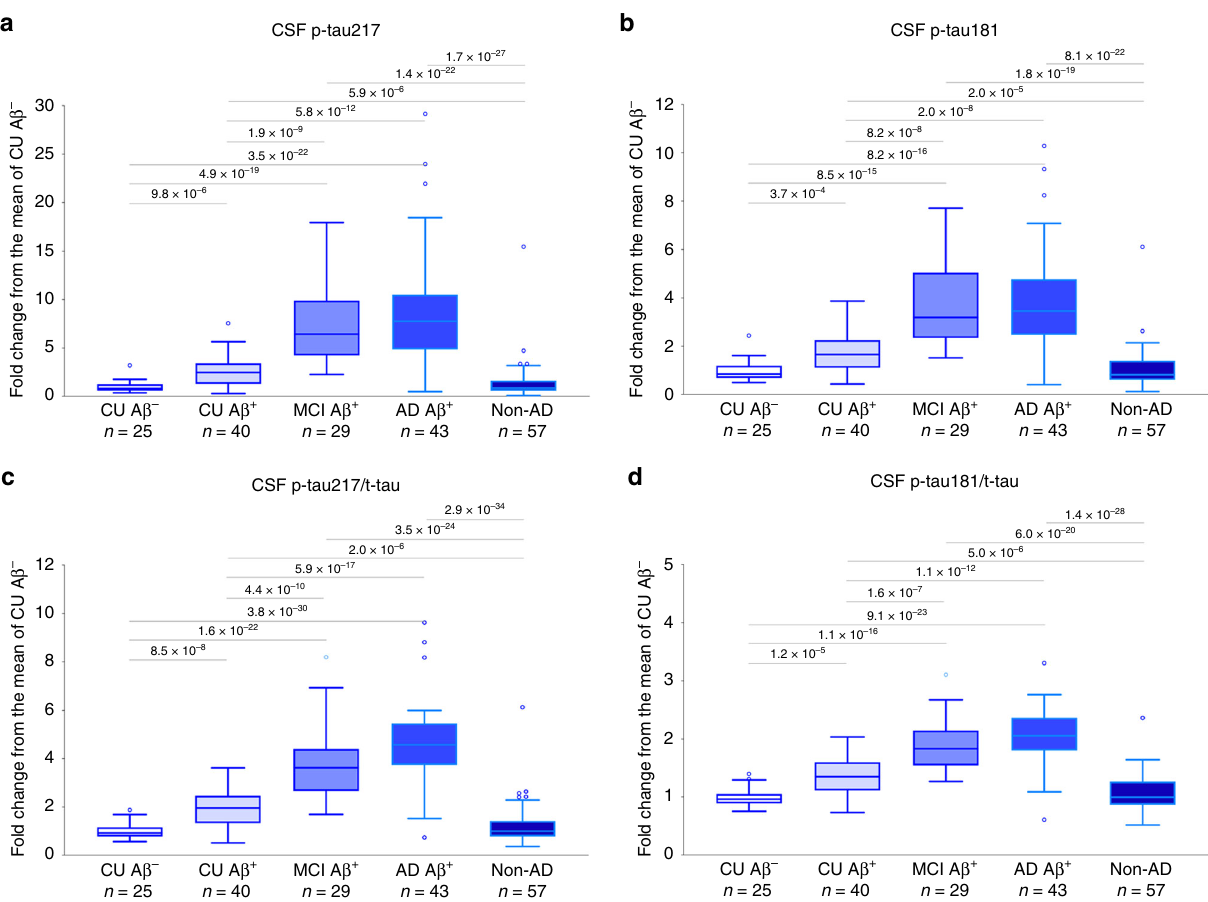
Fig. 1 CSF p-tau in diagnostic groups. a CSF p-tau217, b CSF p-tau181, c CSF p-tau217/t-tau, and d CSF p-tau181/t-tau in CU A β + ( n = 25), CU A β + ( n = 40), MCI A β + ( n = 29), AD A β + ( n = 43) and non-AD neurodegenerative disorders ( n = 57). Non-AD neurodegenerative disorders group included 10 PD, 17 PDD, 6 PSP, 7 DLB, 7 CBS, 4 SD, and 6 bvFTD patients. P values (unadjusted for multiple comparisons) are from univariate general linear models adjusted for age and sex; boxes show interquartile range, the horizontal lines are medians and the whiskers were plotted using Tukey method. Abbreviations: AD Alzheimer ’ s disease, bvFTD behavioral-variant frontotemporal dementia, CBS corticobasal syndrome, CSF cerebrospinal fl uid, CU cognitively unimpaired controls, DLB dementia with Lewy bodies, MCI Mild Cognitive Impairment, PD Parkinson ’ s disease, PDD Parkinson ’ s disease with dementia, PSP progressive supranuclear palsy, SD semantic Group comparisons . CSF p-tau217 and p-tau181 were highly correlated (whole cohort Pearson r = 0.973, p = 8.8 × 10 − 125 ; CU Pearson r = 0.979, p = 1.8 × 10 − 45 ; A β + MCI Pearson r = 0.972, p = 2.0 × 10 − 18 ; AD dementia Pearson r = 0.958, p = 8.6 × 10 − 24 ;